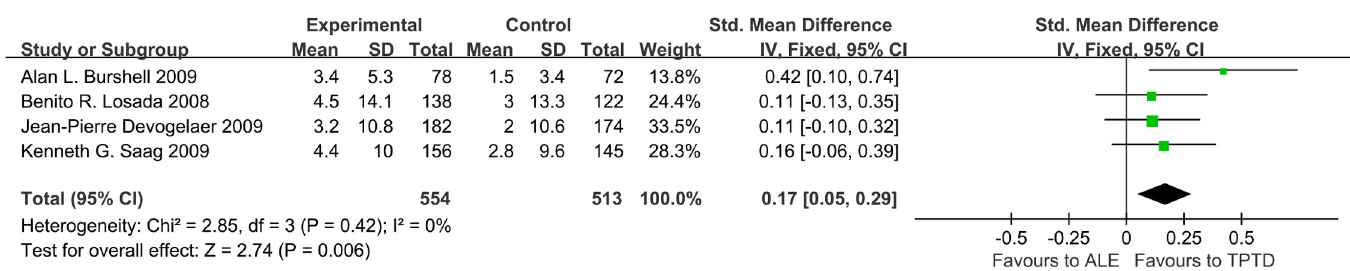
Fig 7. Forest plots of mean percent change from baseline to 18 months in the FN BMD.